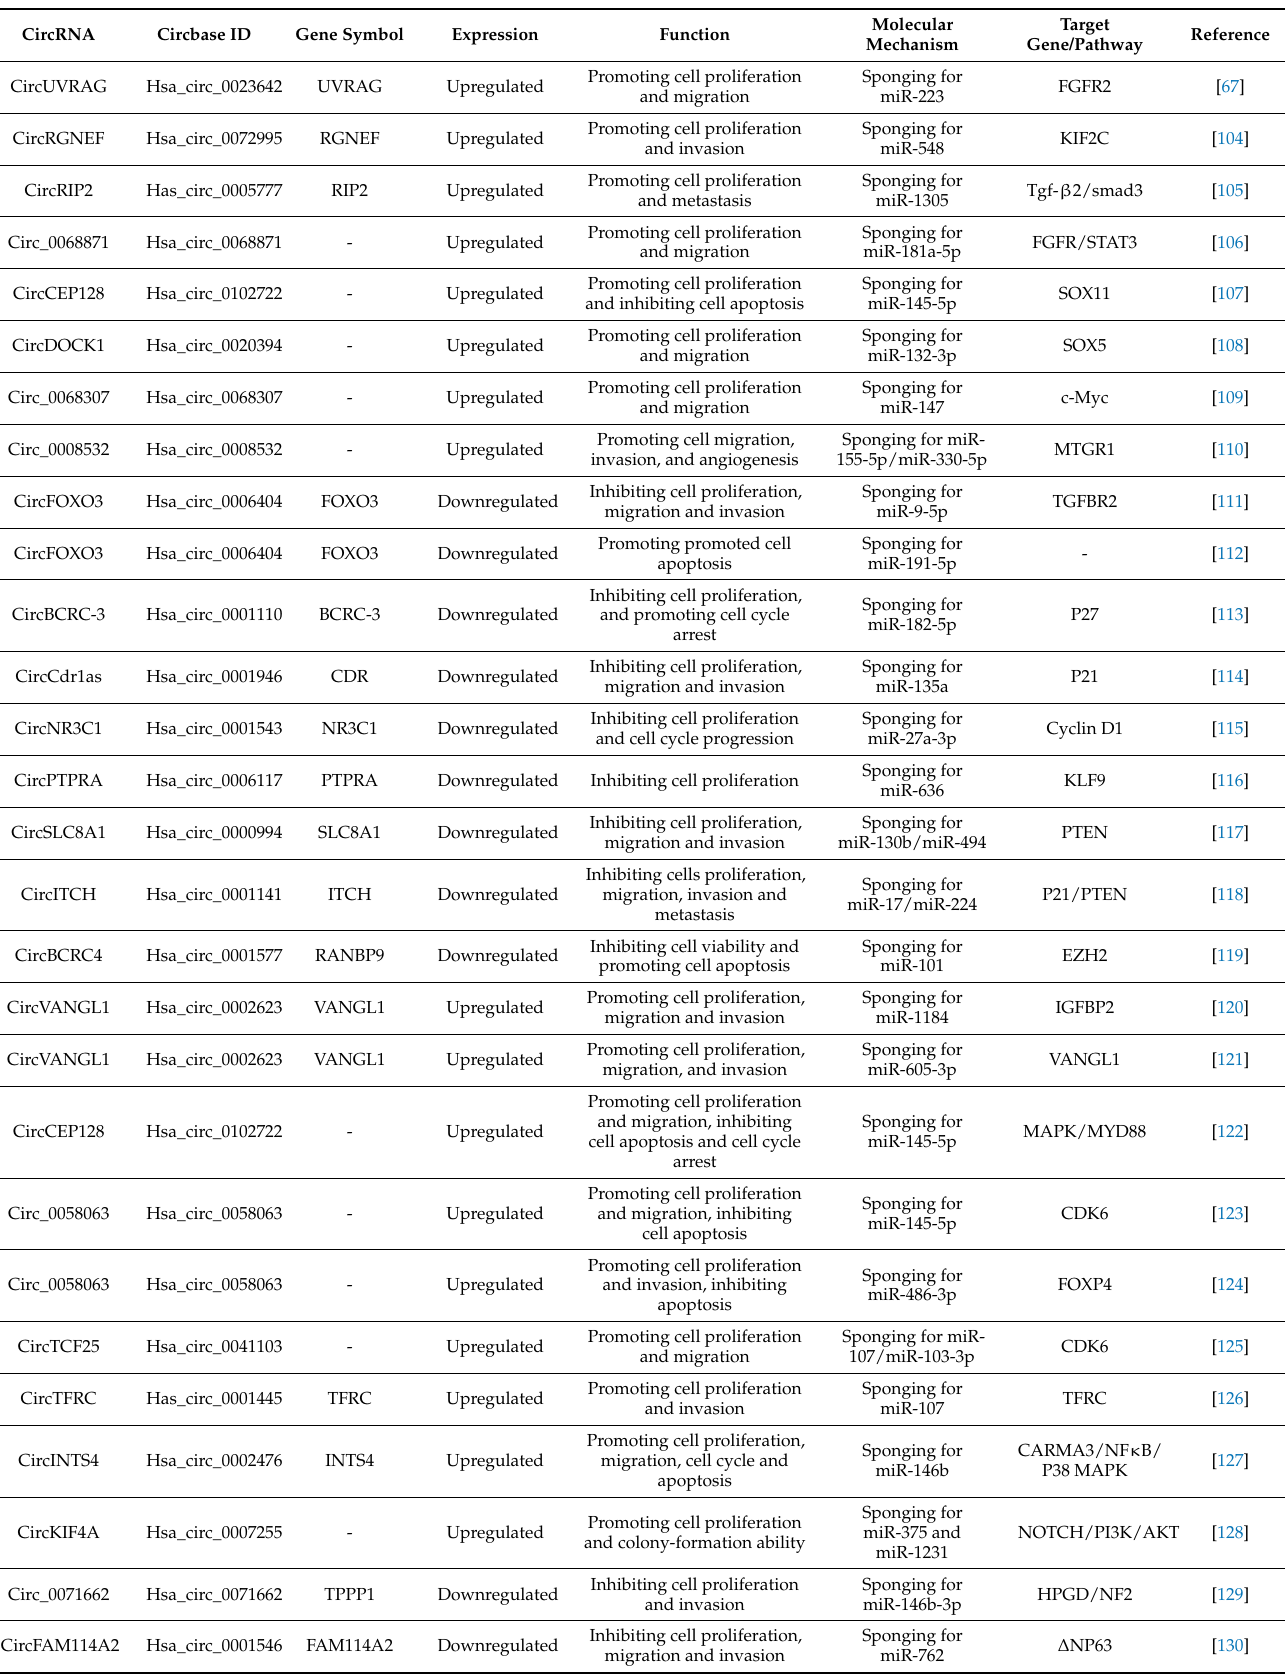
Table 1. CircRNAs and their mechanisms in bladder cancer